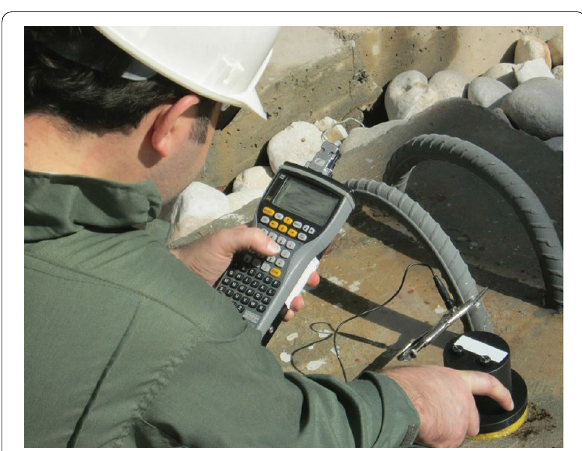
Fig. 3 The measurement of corrosion rate by galvanostatic pulse technique (Beirami & Ehteshamzadeh,